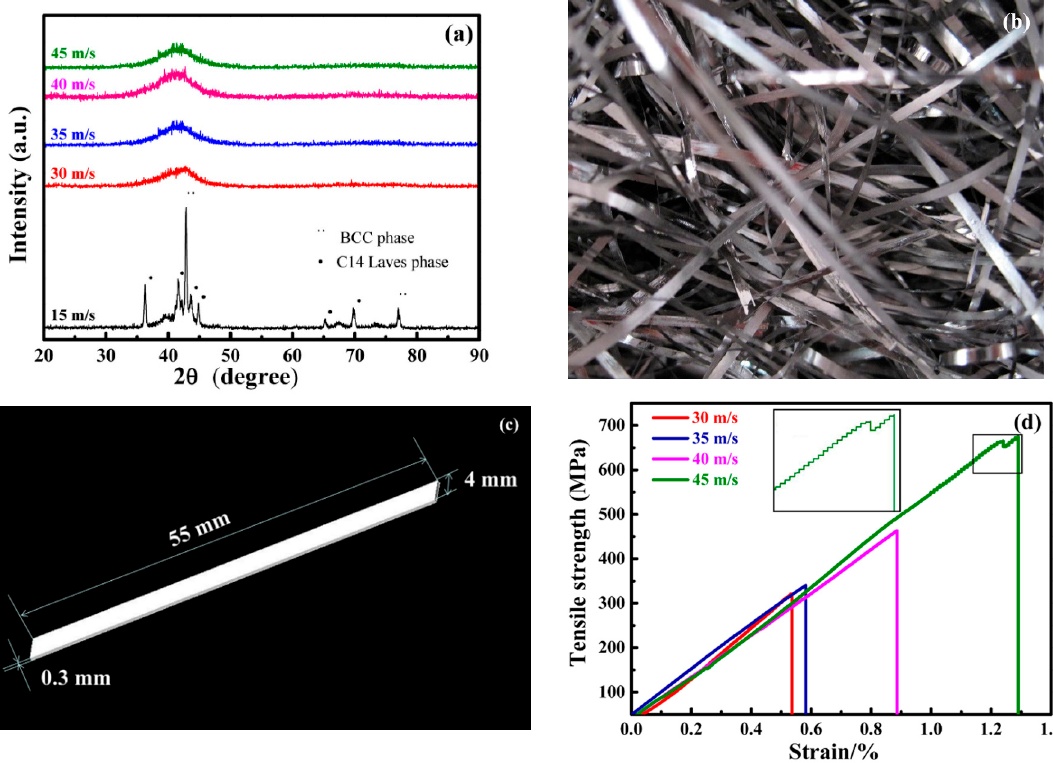
Figure 1. ( a ) XRD patterns of (TiZr) 0.5 (Ni 0.6 Cr 0.1 V 0.1 ) 2.1 amorphous ribbons with different spinning speeds; ( b ) shapes of (TiZr) 0.5 (Ni 0.6 Cr 0.1 V 0.1 ) 2.1 amorphous ribbons; ( c ) the model of ribbons in the tensile test; ( d ) stress–strain curves of amorphous (TiZr) 0.5 (Ni 0.6 Cr 0.1 V 0.1 ) 2.1 alloy with different spinning speeds. Table 1. Tensile strength, elongation, and elastic modulus of amorphous (TiZr) 0.5 (Ni 0.6 Cr 0.1 V 0.1 ) 2.1 ribbons at different spinning speeds.